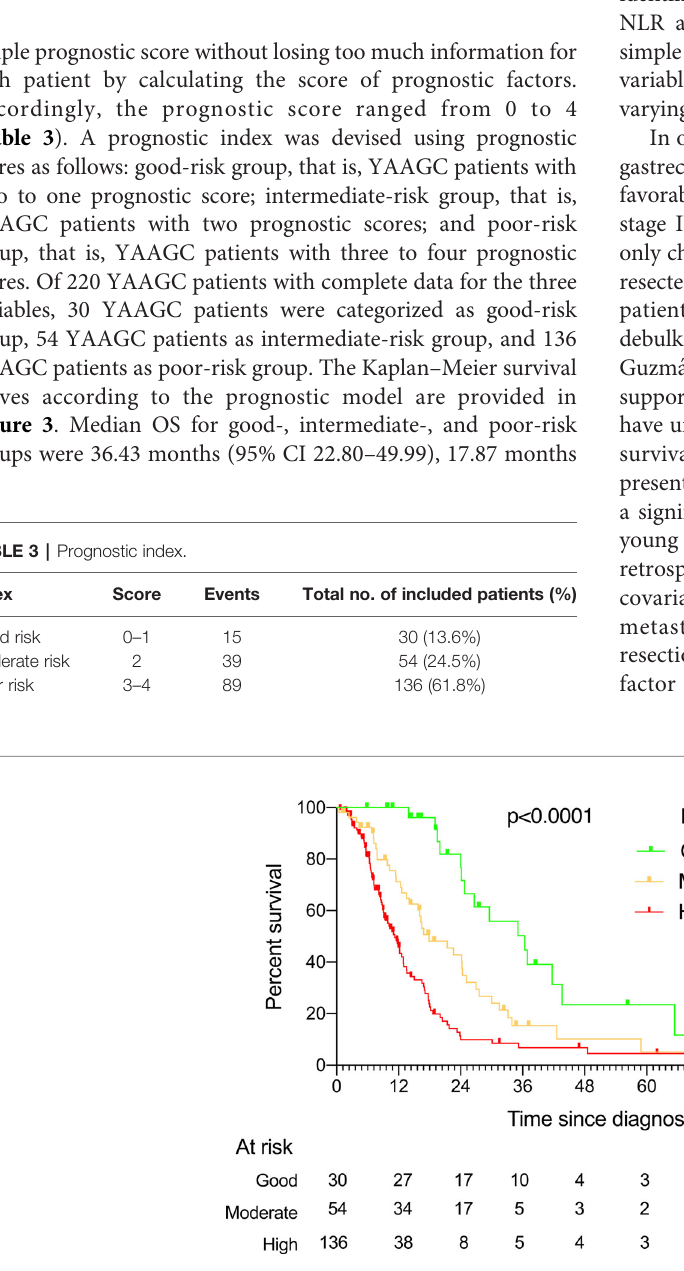
FIGURE 3 | The Kaplan – Meier curves showing overall survival for each of the three risk groups determined by the prognostic factors. The median survival and the patients at risk for each of these groups are also presented.